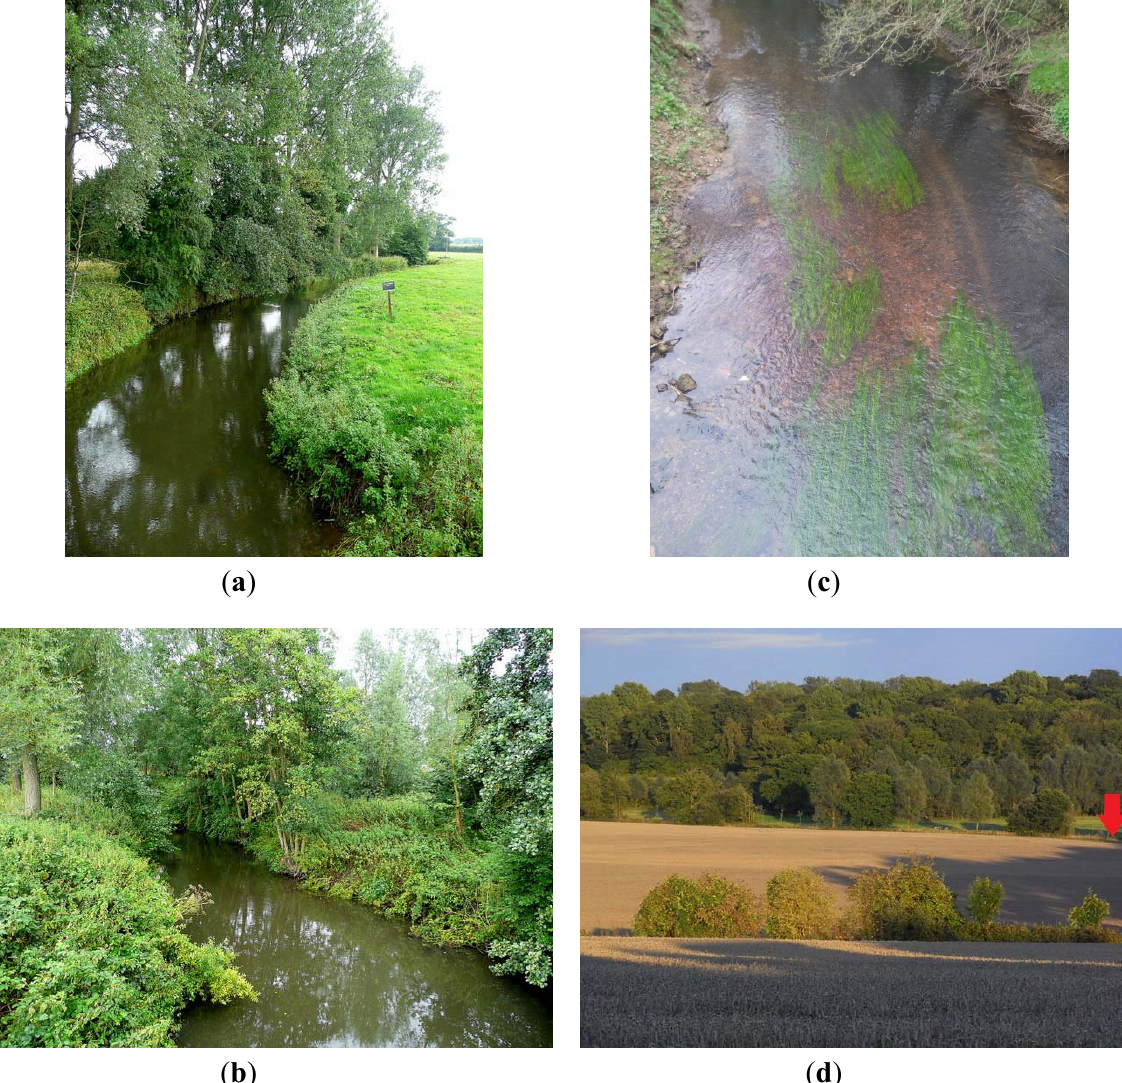
Figure 2. Photographs of the Enborne catchment: ( a ) The River Enborne—view upstream from Shalford Bridge (SU569649) on 31 July 2009; ( b ) view downstream from Shalford Bridge on 31 July 2009 both © copyright Jonathan Billinger and licensed for reuse under a Creative Commons Licence (CCL); ( c ) Macrophyte growth on the River Enborne (SU557633), just upstream of its confluence with Baughurst Brook on 31 March 2012; and ( d ) Fields